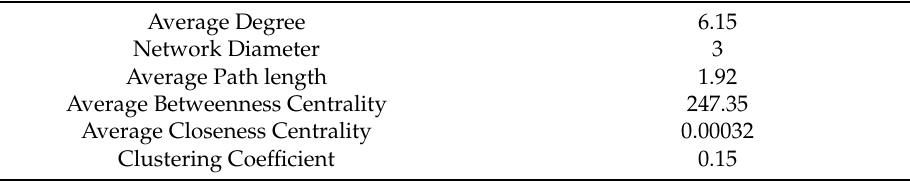
Table 2. Metrics of the production data-exchange